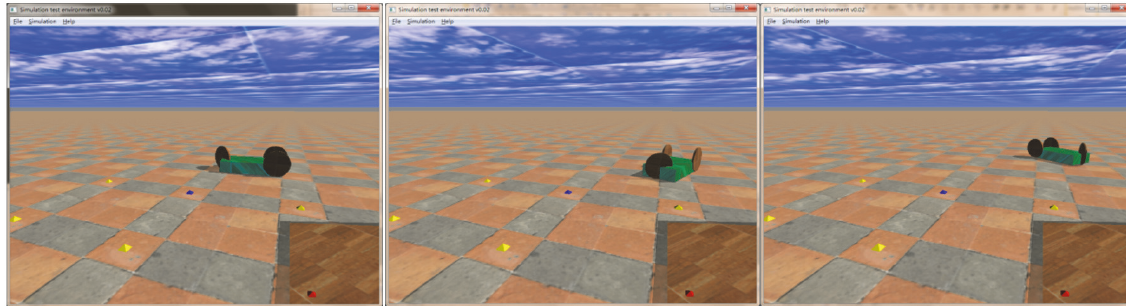
Figure 7: Horizontal